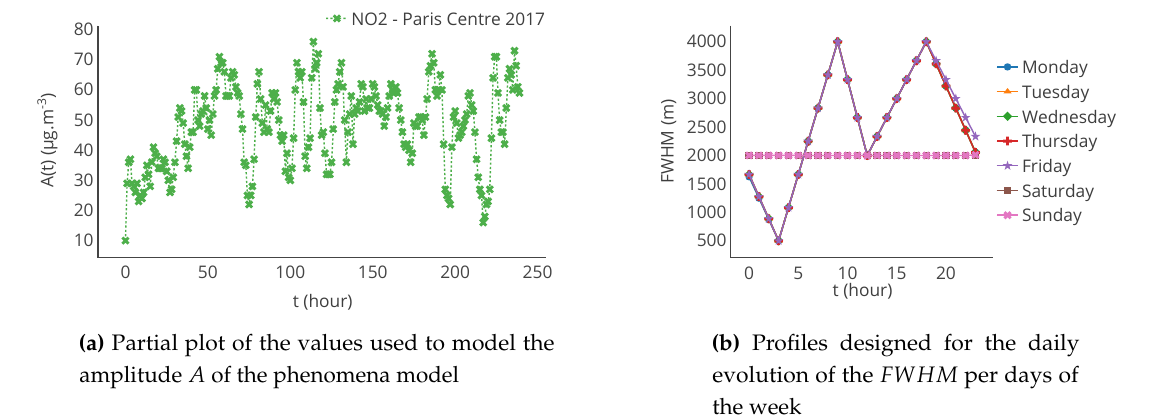
Figure 4. Evolution of A and FWHM for the modelling of the concentration of